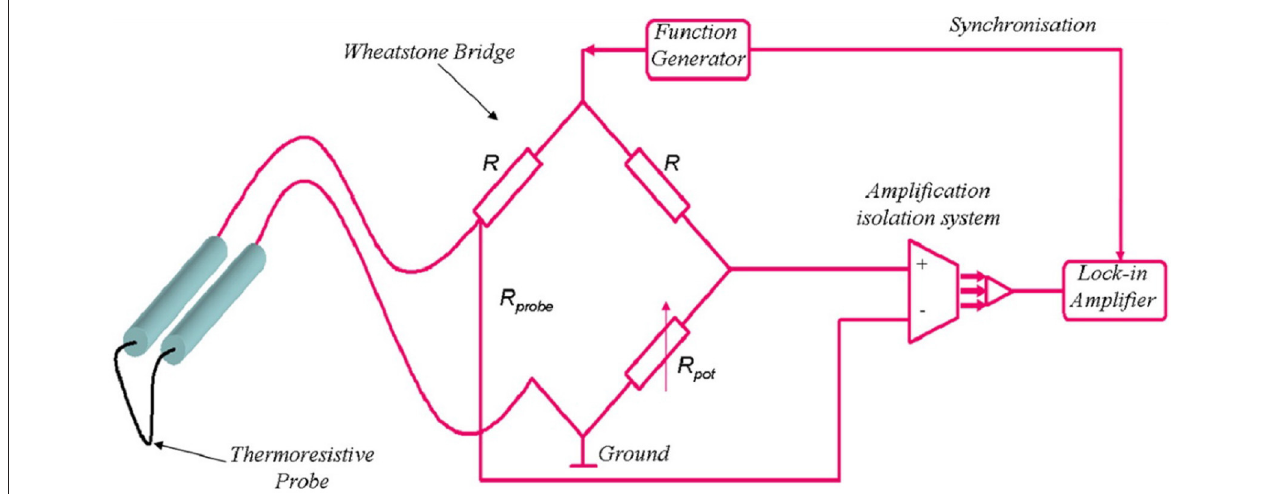
FIGURE 13 | 3 ω -scanning thermal microscopy measurement. Reprint with permission from Grauby et al. (2013). Copyright 2013 American Chemical